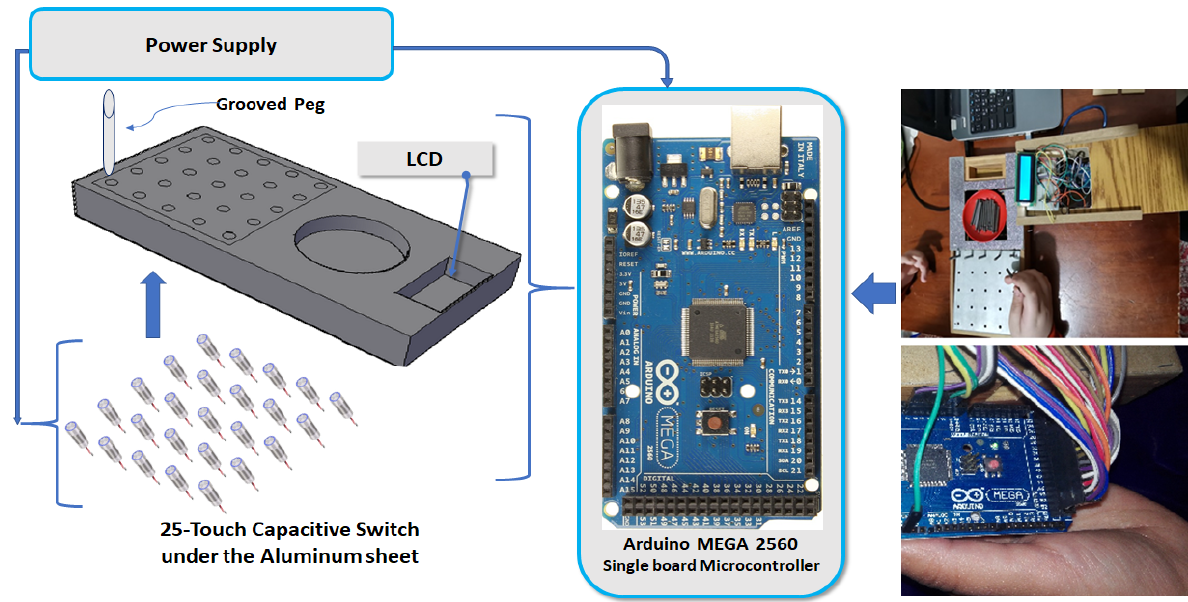
Figure 3. Images of the experimental electric circuit.